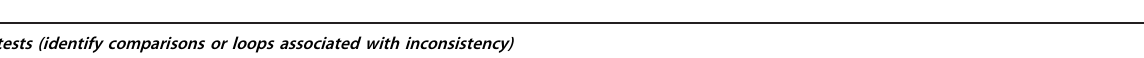
of Figure 1. The full list of the 186 networks and their characteristics can be found in http://www.mtm.uoi.gr/.